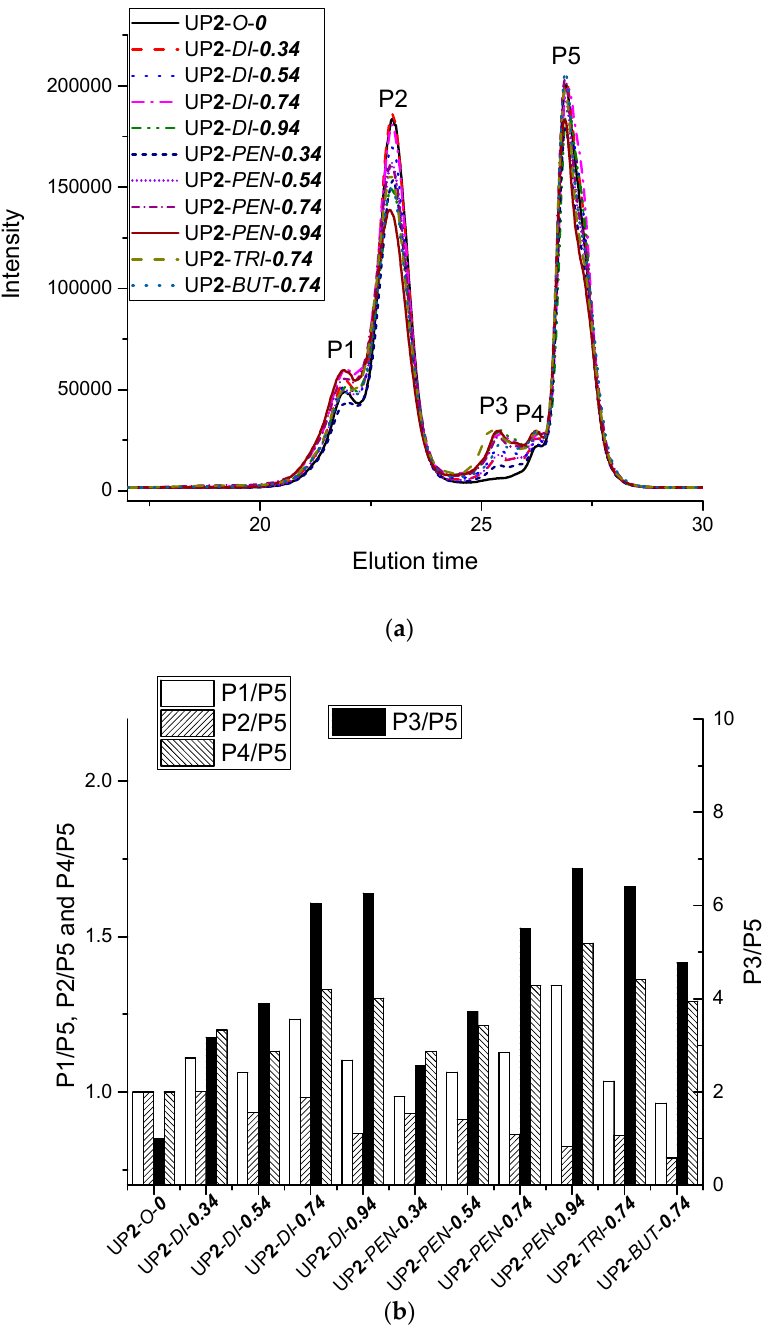
Figure 10. ( a ) Size exclusion chromatography (SEC) chromatograms of the samples made via the two-stage process; ( b ) The relative intensities of peaks P1/P5, P2/P5, P3/P5 and P4/P5 are compared to the blank sample UP 2 - O - 0 . to the blank sample UP 2 - O - 0